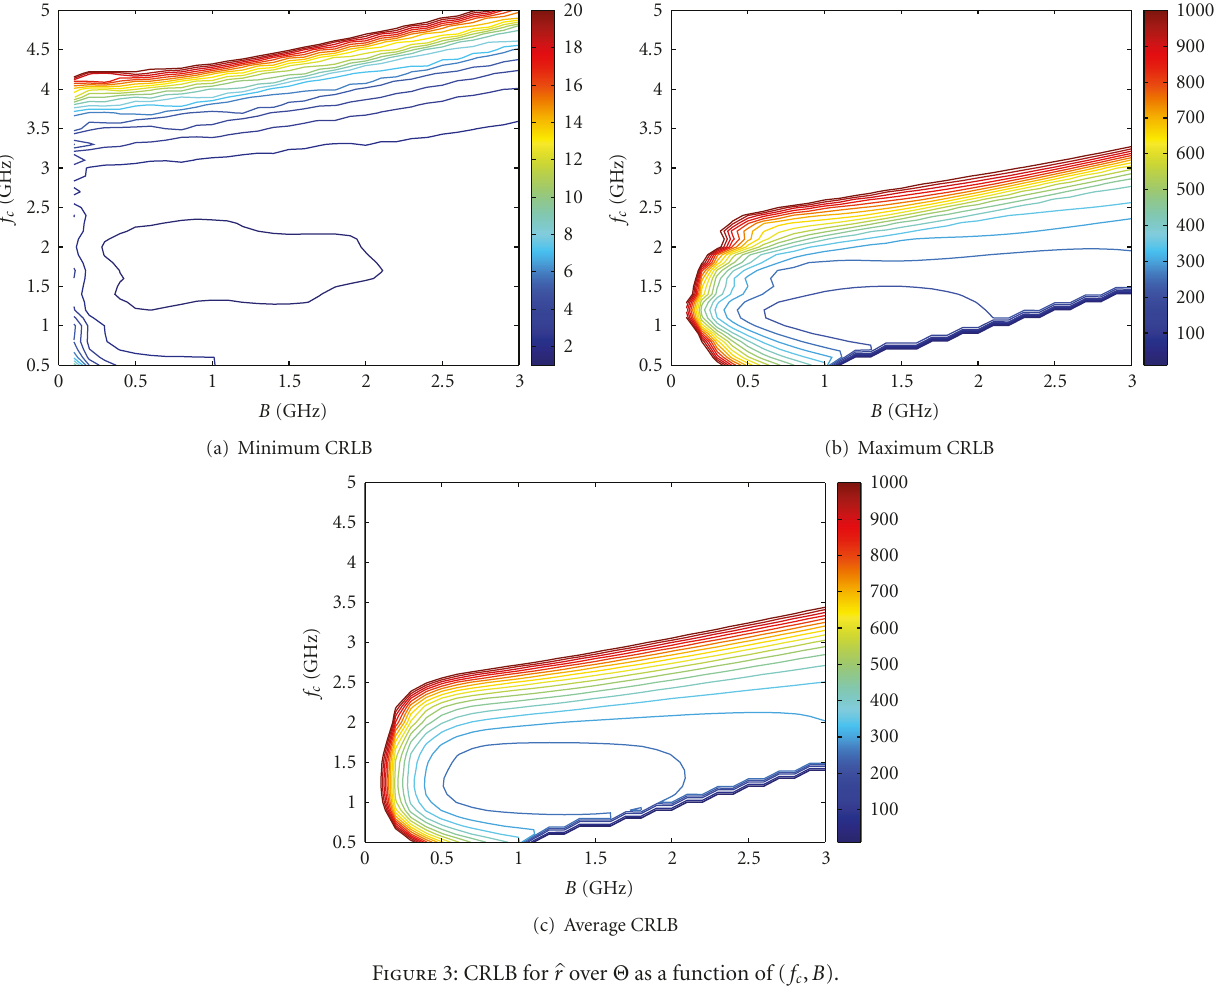
reducing the E sd /N 0 ratio while all other parameters are kept constant, θ = (13cm,10mm,0 .